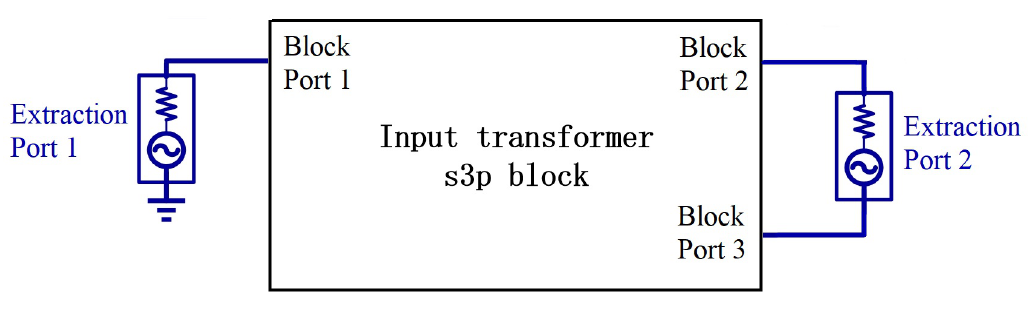
Figure 13. Testbench for parameter extraction of the input transformer.